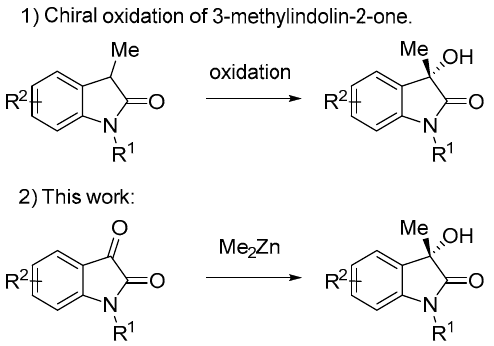
Figure 1. Biologically active 3 ‐ hydroxy ‐ 3 ‐ methyl ‐ 2 ‐ oxindole